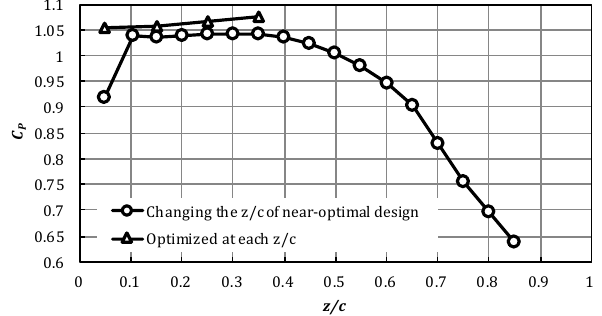
Figure 10. Variation of C P with z/c .